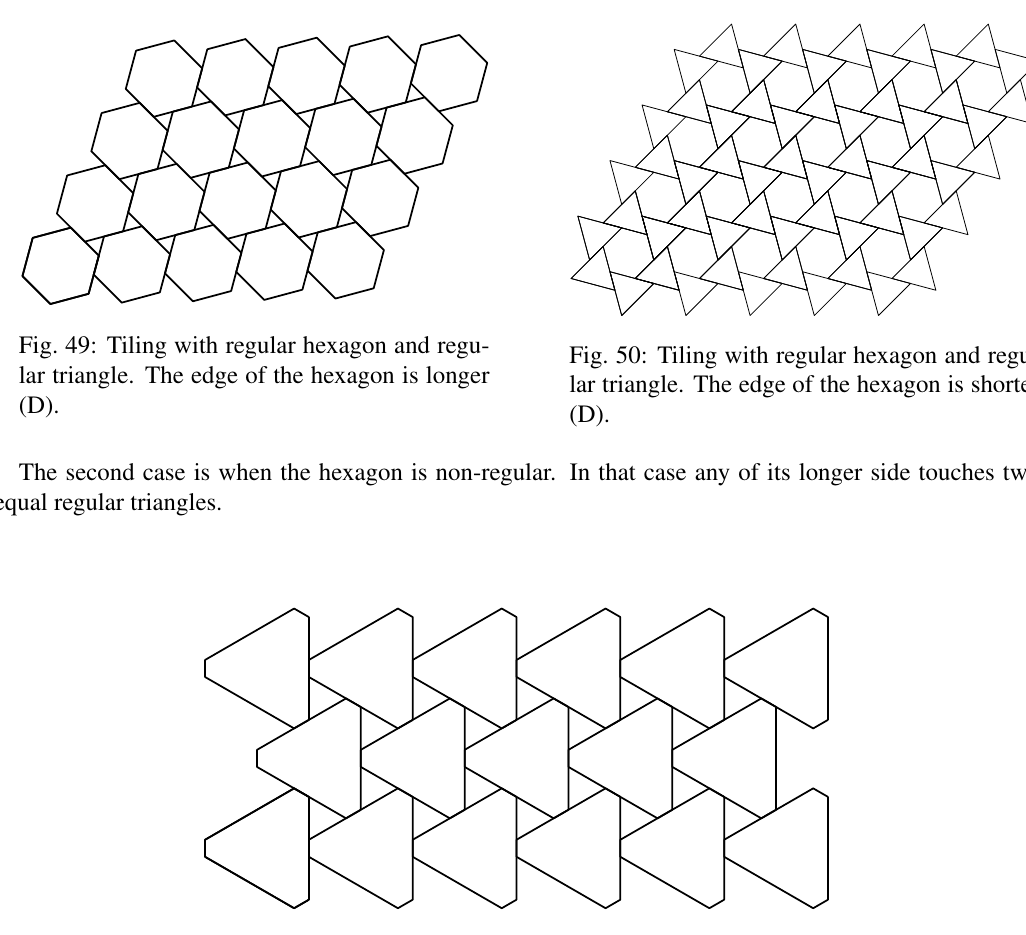
Fig. 51: Tiling with regular triangle and non-regular